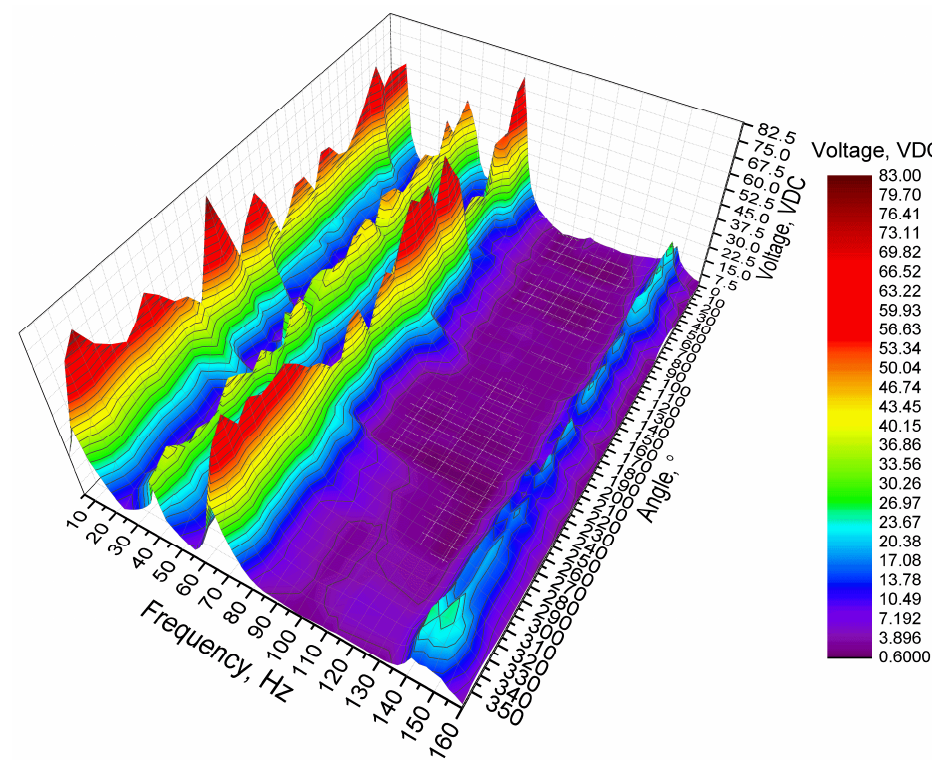
Figure 14. Open-circuit voltage characteristics of the energy harvester.